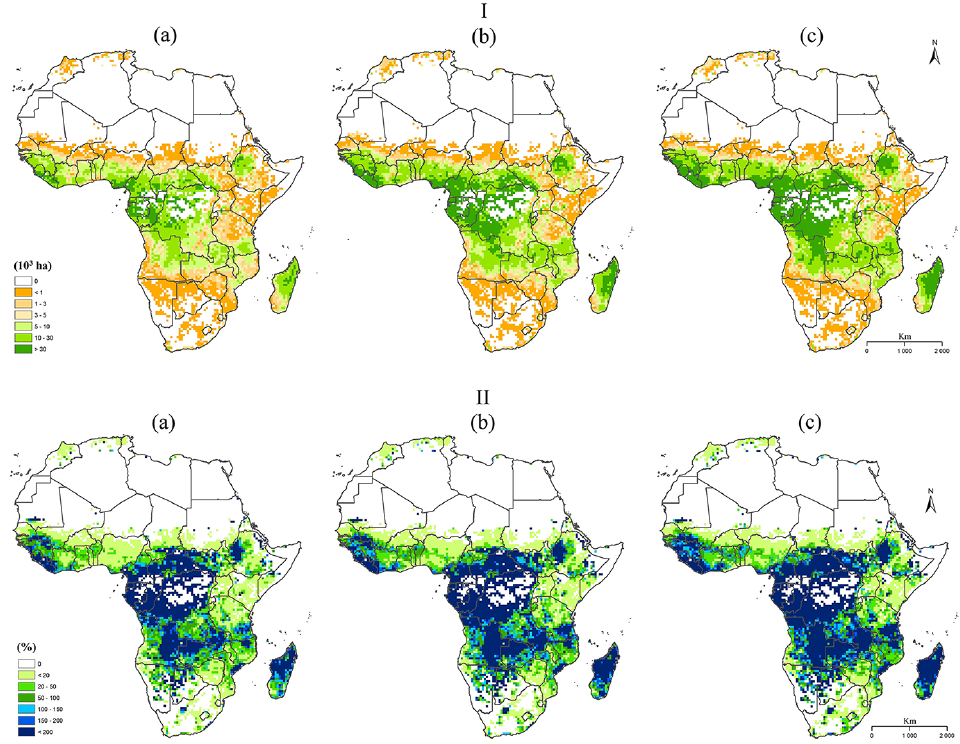
Figure 6. (I) Total area irrigable with groundwater inside a cell (0.5 ◦ × 0.5 ◦ ) in 10 3 ha and (II) proportion of cropland irrigable with ground- water, for various levels of environmental groundwater requirements as a fraction of recharge: (a) Scenario 1: 70%, (b) Scenario 2: 50%, (c) Scenario 3: